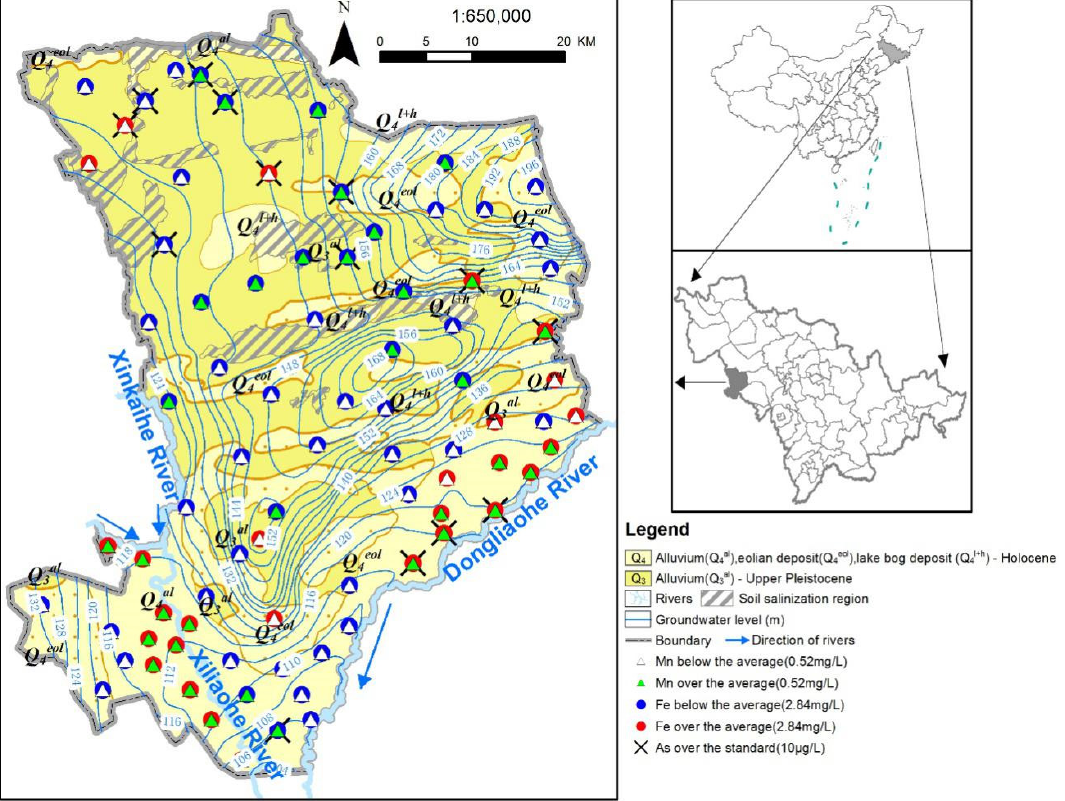
Figure 1. Location and geology map of the study area showing sample locations and rivers.